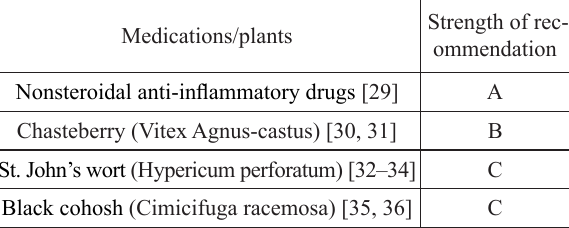
Clinical efficacy of medicines for PMS